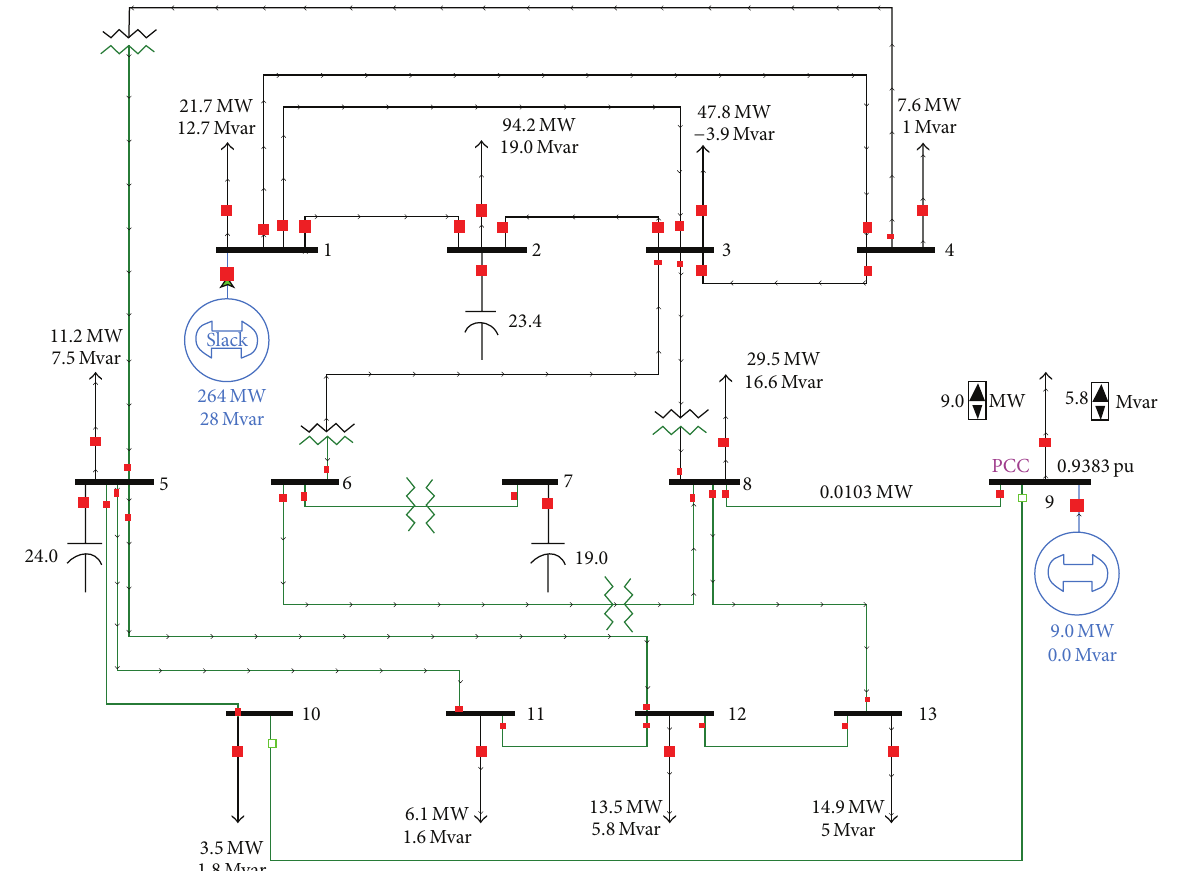
Figure 6: DG in 13-bus system.